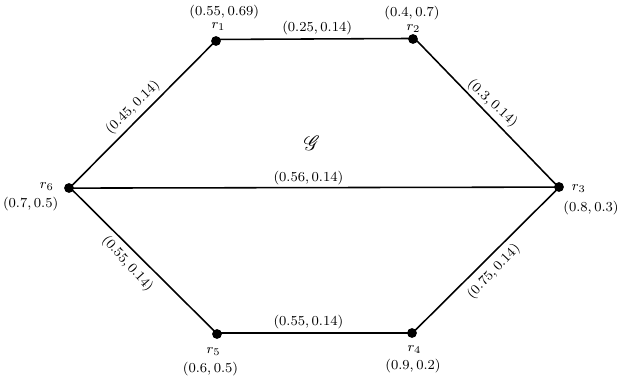
Figure 6.4: Pythagorean fuzzy planar graph Figure 15. Pythagorean fuzzy planar graph. The Pythagorean fuzzy dual graph G of G is displayed in Figure ?? 1 26 Figure 6.5: Pythagorean fuzzy dual graph